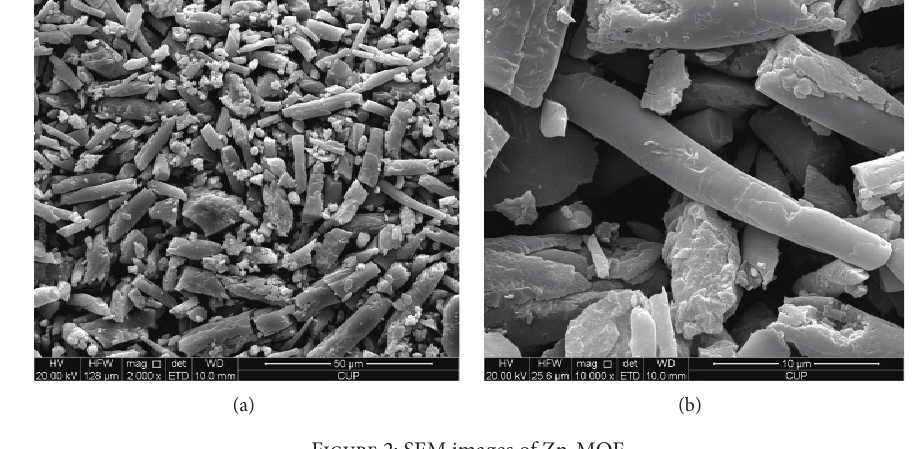
Figure 2: SEM images of Zn-MOF. Table 2: Effects of temperature on the distribution of